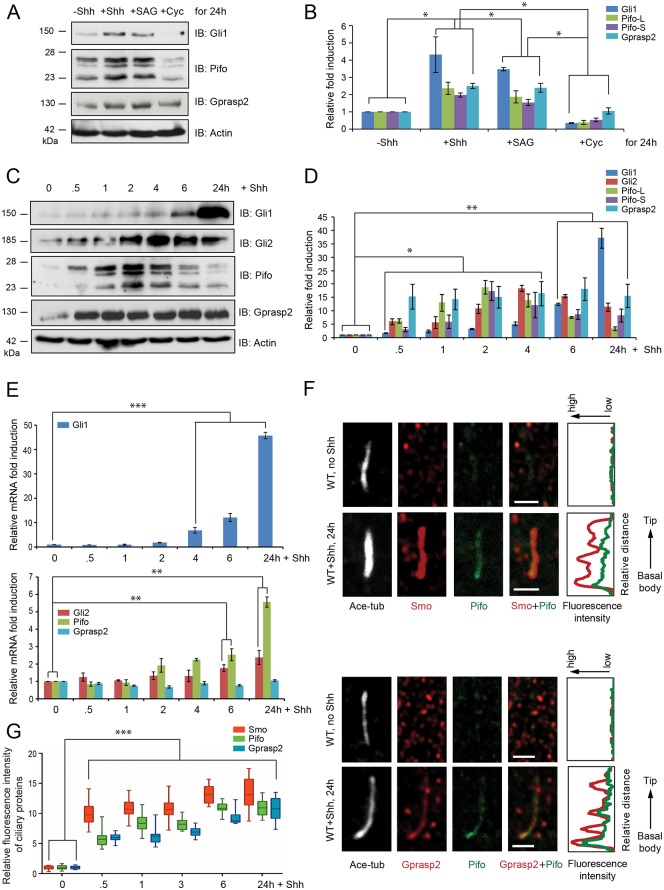
Rapid Shh induction of Pifo, Gprasp2 and Gli2 is regulated on transcriptional and post-translational level.(A) The levels of Gli1, Pifo and Gprasp2 protein after treatment with Shh, SAG, or Cyc in PLCs. Graphs (B, D) represent quantification of immunoblot data that show the mean fold change of protein expression normalized to Actin levels. Characterization of induction kinetics of Gli1, Gli2, Pifo, and Gprasp2 proteins (C) and mRNAs (E) in response to Shh stimulation in PLCs. Representative confocal images for co-localization analysis of ciliary Pifo and Smo or Gprasp2 (F) and quantification (G) of ciliary accumulation in response to Shh stimulation. >100 cilia per condition were analyzed. All error bars indicate the mean ± SD of three independent experiments. Data were analyzed using a two tailed unpaired t-test (B, D, E) or a two way ANOVA (G) (* = p<0.1, ** = p<0.01, *** = p<0.001)